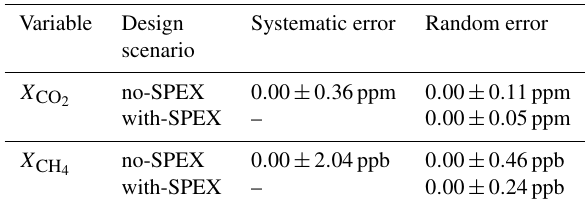
Table 5. Parameterisation approximation